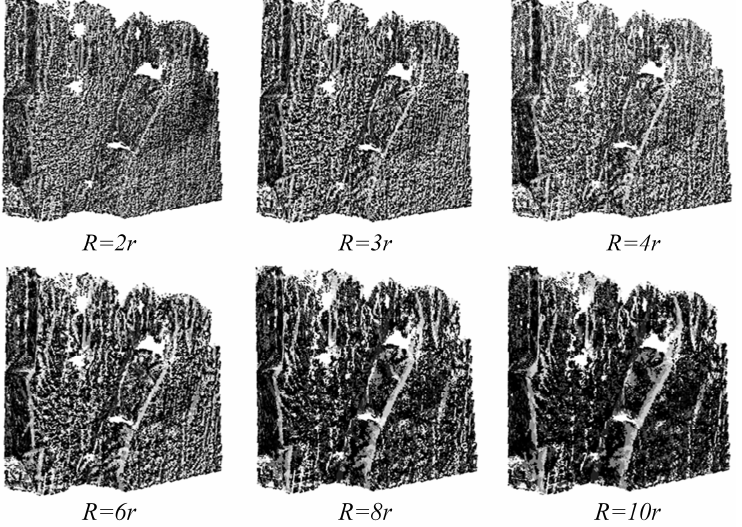
Figure 10. MS-LBP models at different scales ( r is the average spacing of the original point cloud).